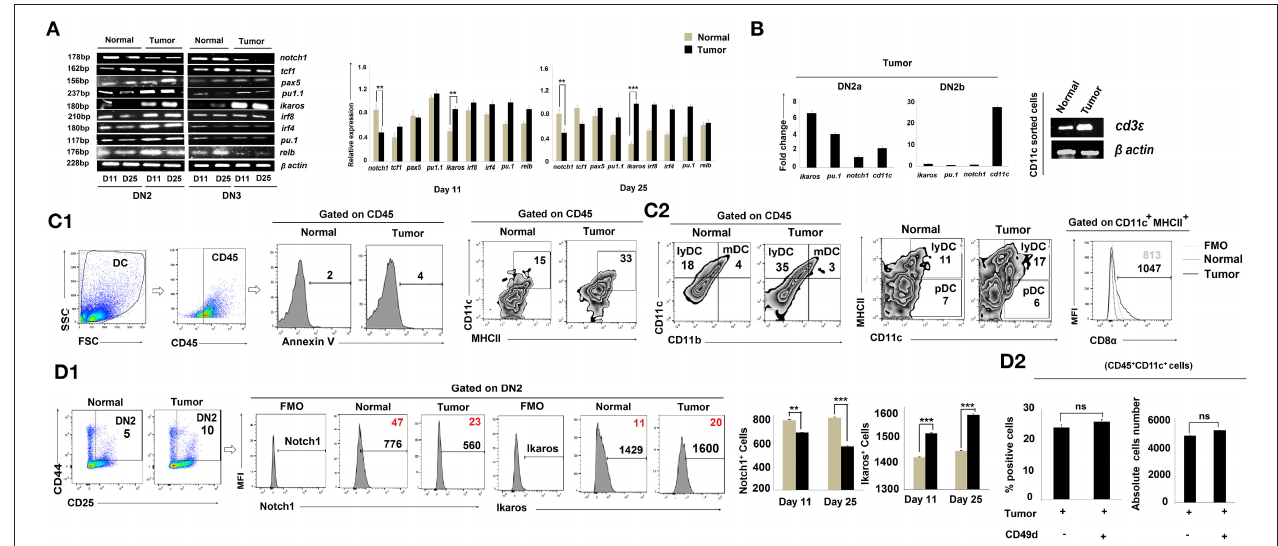
FIGURE 4 | Tumor microenvironment induces DC lineage commitment of DN2 pro-T cells. (A) Thymic T cells from normal and tumor hosts were sorted for CD25 + CD44 + and CD25 + CD44 − cells as DN2 and DN3 by flow cytometry on days 11 and 25 after tumor inoculation. Different gene expressions for different transcription factors were checked by RT-PCR using mRNA from thymic T cells, keeping β -actin as a loading control. notch1 and tcf1 were checked for T cells, pax5 for B cells, pu1.1 for macrophages, and ikaros , irf8 , irf4 , pu.1 , and relb for myeloid lineage commitment. Representative expression patterns of genes are presented in the left panel along with bar diagrams showing mean ± SE of expression of mentioned transcription factors from normal and tumor hosts on days 11 and 25, respectively ( n = 4); ** p < 0.01, *** p < 0.001. (B) Thymic T cells from normal and tumor hosts were sorted for CD25 + CD44 + c-Kit high and CD25 + CD44 + c-Kit low cells as DN2a and DN2b by flow-cytometry on day 25 after tumor inoculation. From the mRNA, different gene expressions were checked by quantitative real-time PCR, keeping β -actin as a housekeeping gene. Ct values were calculated, and fold change of Ct value against experimental control was represented by mean ± SE in a bar diagram ( n = 3). The right panel shows the gene expression pattern of cd3 ε from CD11c + -sorted thymic cells from normal and tumor hosts using β -actin as a loading control. (C1,C2) The total percentages of dendritic cells of normal and tumor-bearing mice were checked by flow cytometry. Thymic cells were stained with CD45, Annexin V, CD11c, MHCII, CD11b, and CD8 α . Gating strategies of staining are shown, and flow-cytometric representations of CD45 + CD11c + MHCII + , CD45 + CD11b − CD11c + (lymphoid DC), CD45 + CD11b + CD11c + (myeloid DC), CD11c + MHCII high CD8 α + (lymphoid DC), and CD11c + MHCII low CD8 α + (Plasmocytoid DC) cells reveal the number of total dendritic cells. (D1) Further validation of Notch1 and Ikaros expression was performed by flow cytometry along with DN2 (CD25, c-Kit) markers from thymic T cells. In histograms, positive percentages of cells are in red. Bar diagrams represent mean ± SE of percentage of DN2 + Notch1 + and DN2 + Ikaros + ( n = 4) cells, respectively; ** p < 0.01, *** p < 0.001. (D2) Increased population of thymus from tumor host was checked after CD49d treatment (4 doses with 48 h interval over a period of 8 days). CD45 + CD11c + dendritic-cell population of thymus from B16 tumor host with or without CD49d treatment was checked